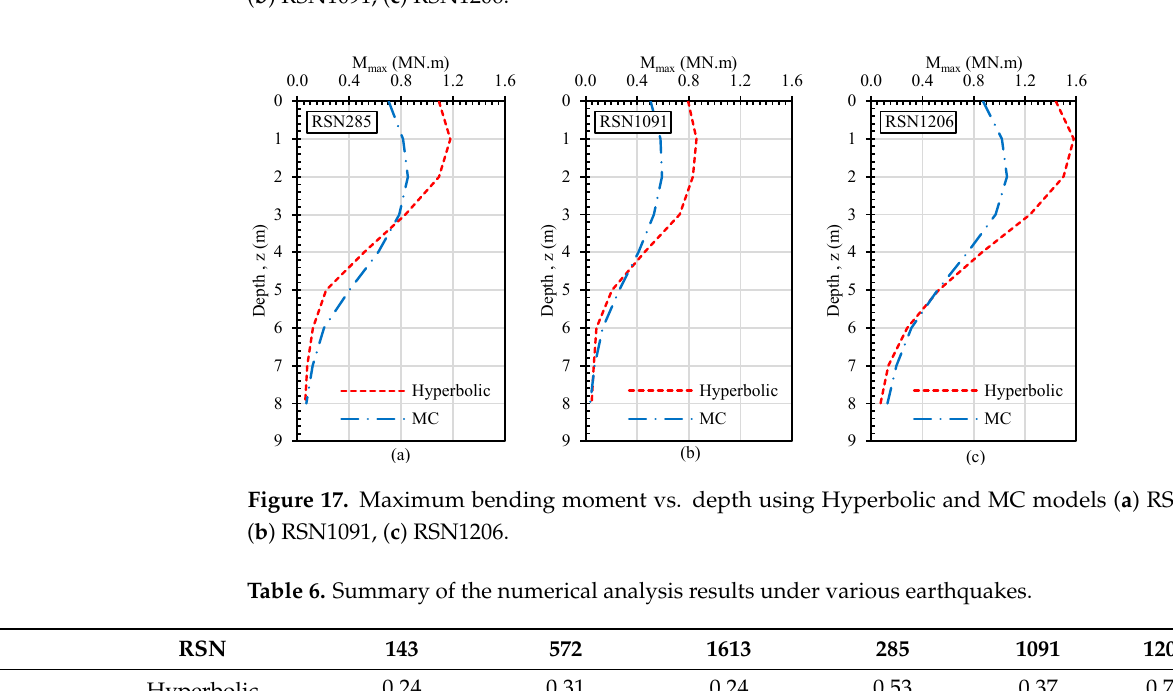
Figure 16. ARS of the superstructure (D = 5%) using Hyperbolic and MC models ( a ) RSN285, ( b ) RSN1091, ( c ) RSN1206.